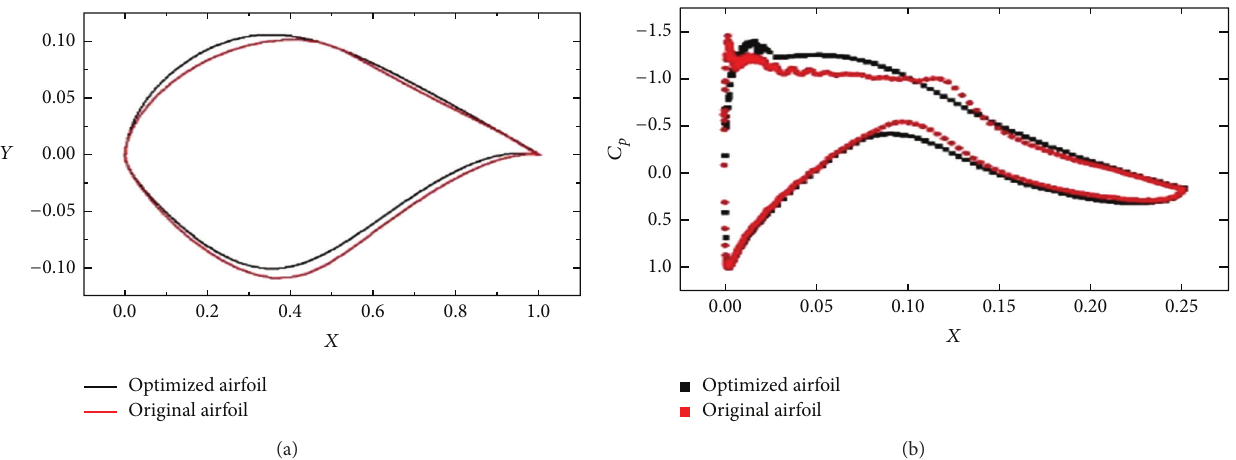
Figure 12: Comparison of original airfoil and optimized airfoil (58% span): (a) shape and (b) pressure distribution.